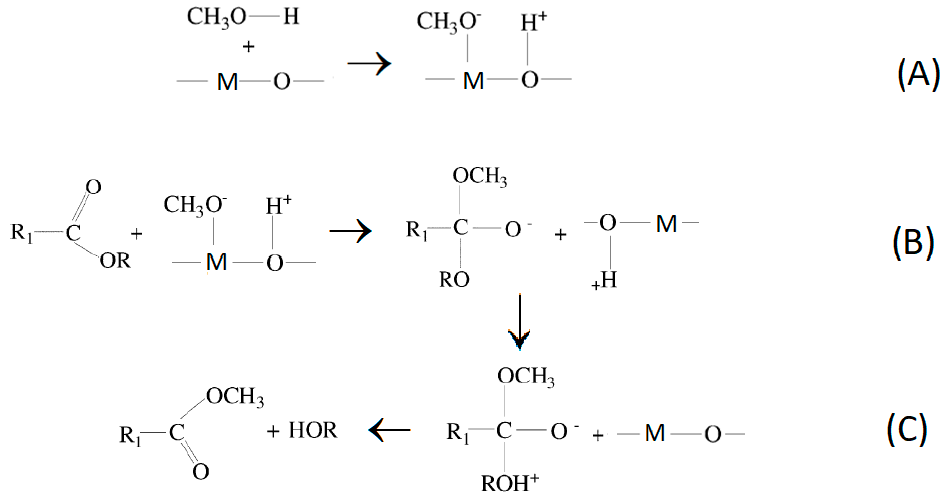
Figure 5. Transesterification reaction scheme over basic solids catalysts, where M–O is a surface basic site created between the metal cation (M) and the O atom. ( A – C ) the steps of reaction see text.